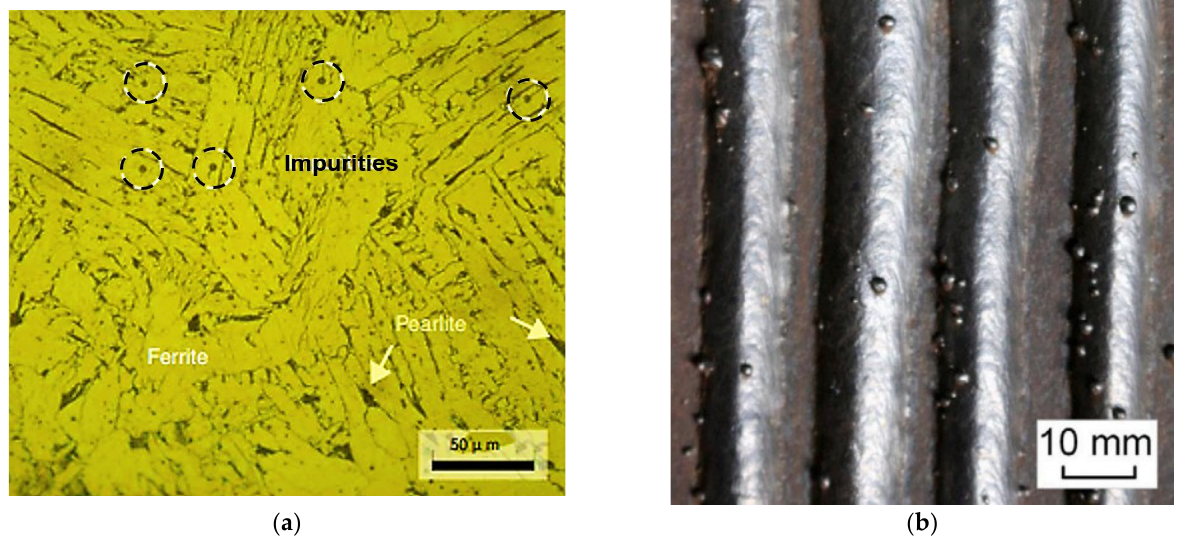
Figure 2. Impurities inclusions ( a ) in an optical micrograph sample of a welded plate, adapted from [10], and ( b ) as slags on the surface of a weld bead, adapted from [11]. from [10], and ( b ) as slags on the surface of a weld bead, adapted from